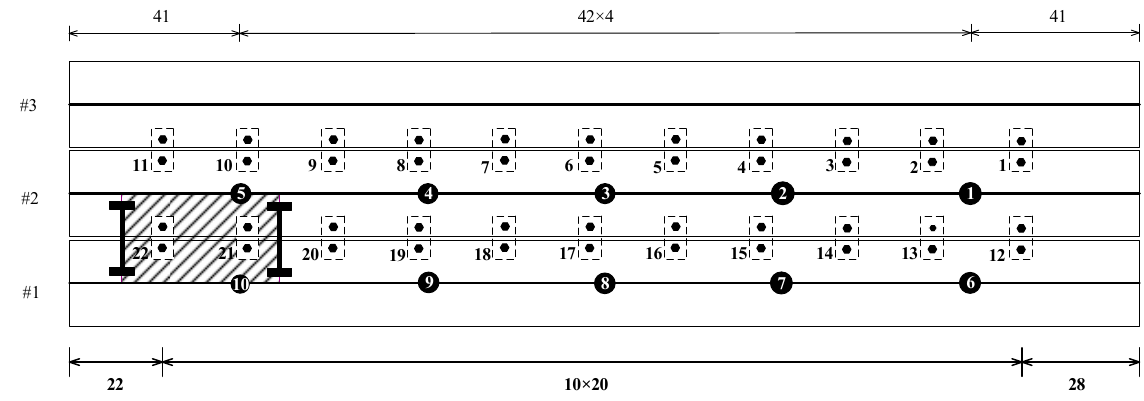
Figure 12. Placement of the sensors and device simulating the damage of the transverse connection (unit: cm).